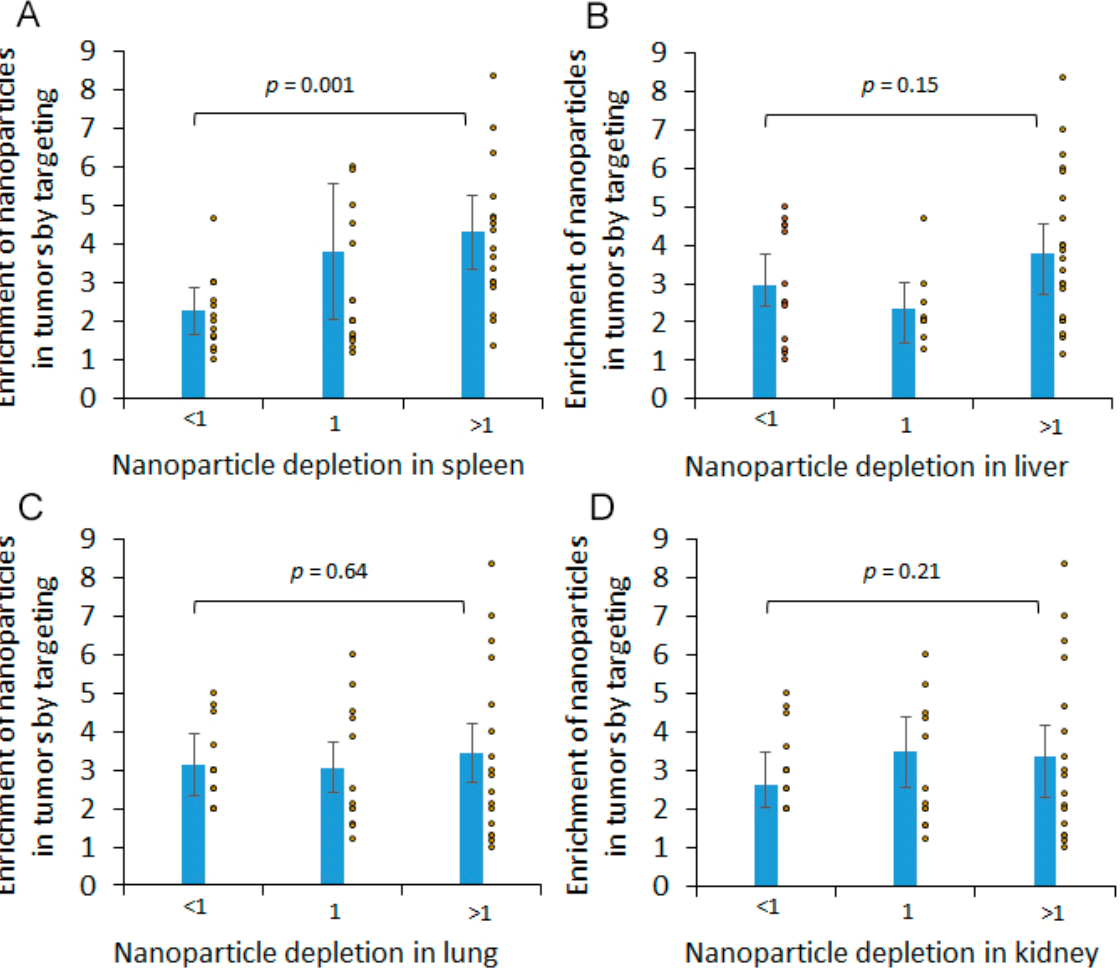
Figure 1. Nanoparticle targeting and biodistribution parameters. Targeting-induced enrichment of nanoparticles in ( A ) spleen, ( B ) liver, ( C ) lungs, and ( D ) kidney. Dots represent individual ENT values and bars represent 95% confidence intervals.